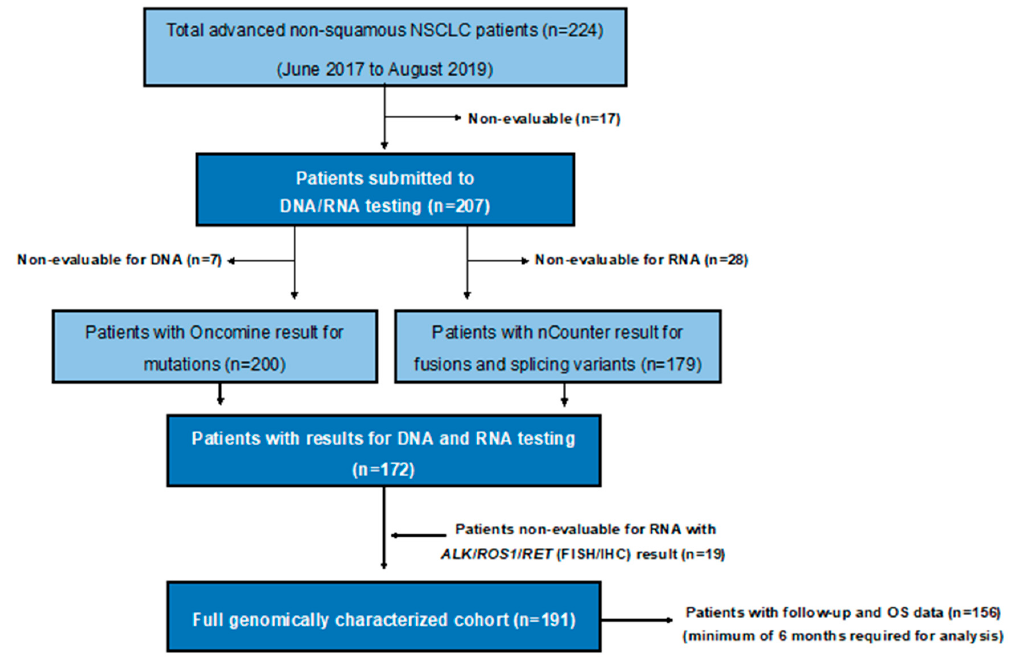
Figure 1. Flow diagram. NSCLC: non-small-cell lung cancer; OS: overall survival; FISH: fluorescence in situ hybridization; IHC: immunohistochemistry.